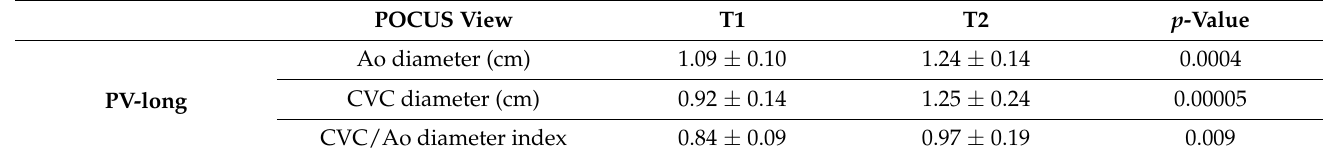
Table 3. Ultrasonographic measurements and calculated variables (mean ± SD) obtained on images from the paralumbar view in 17 calves for the first part of the study (T1) and the second part of the study